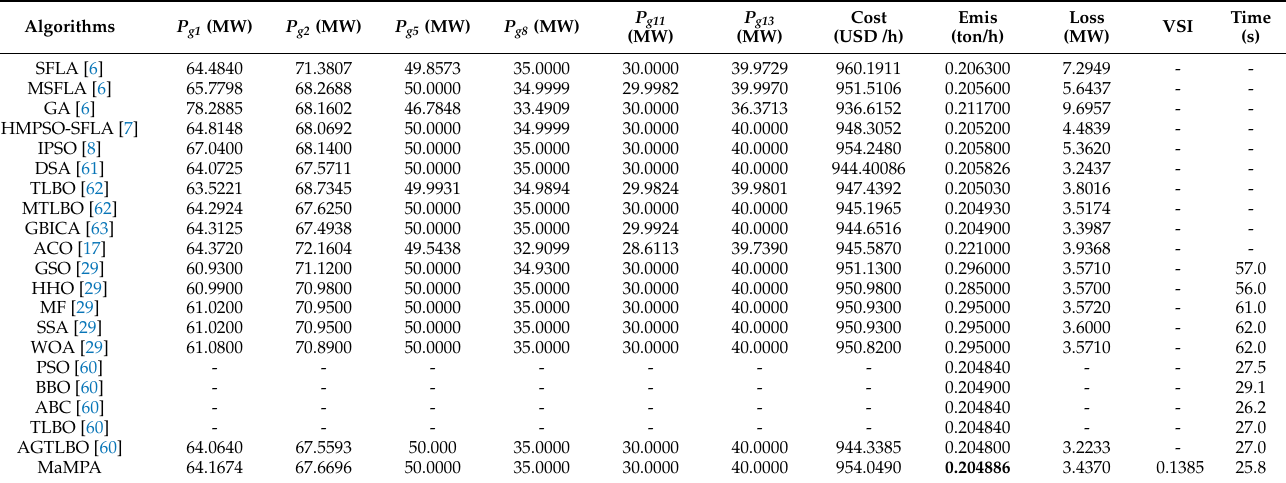
Table 3. Comparison results of case 2.